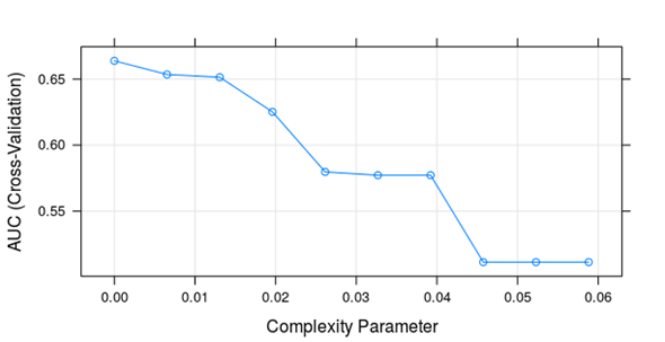
Figure 1: Complexity parameters and its corresponding AUC